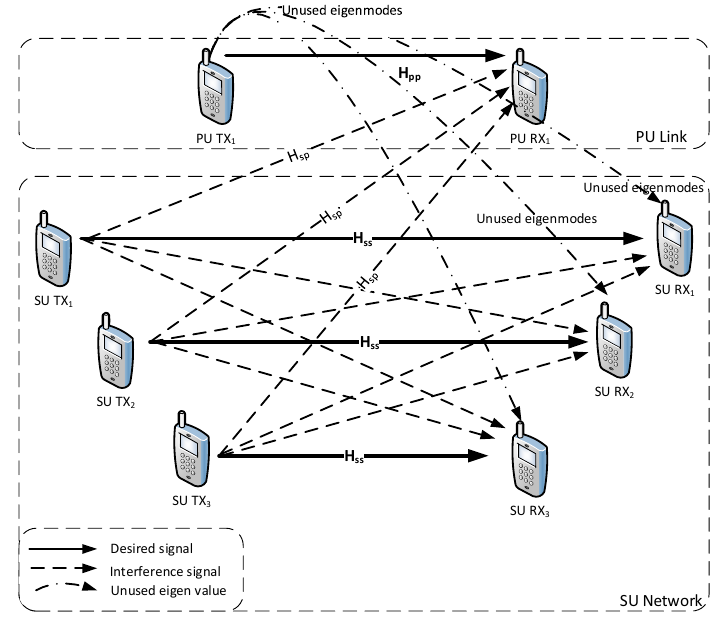
Figure 3. Multiuser CR network model consisting of one PU link and multiple Sus—Paradigm 2.